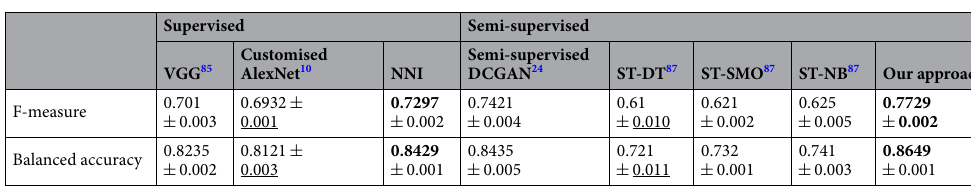
Table 6. Performance comparison between different supervised and semi-supervised approaches. Bold entry highlights the best-performing technique. Underlined entry highlights the worst performing technique.